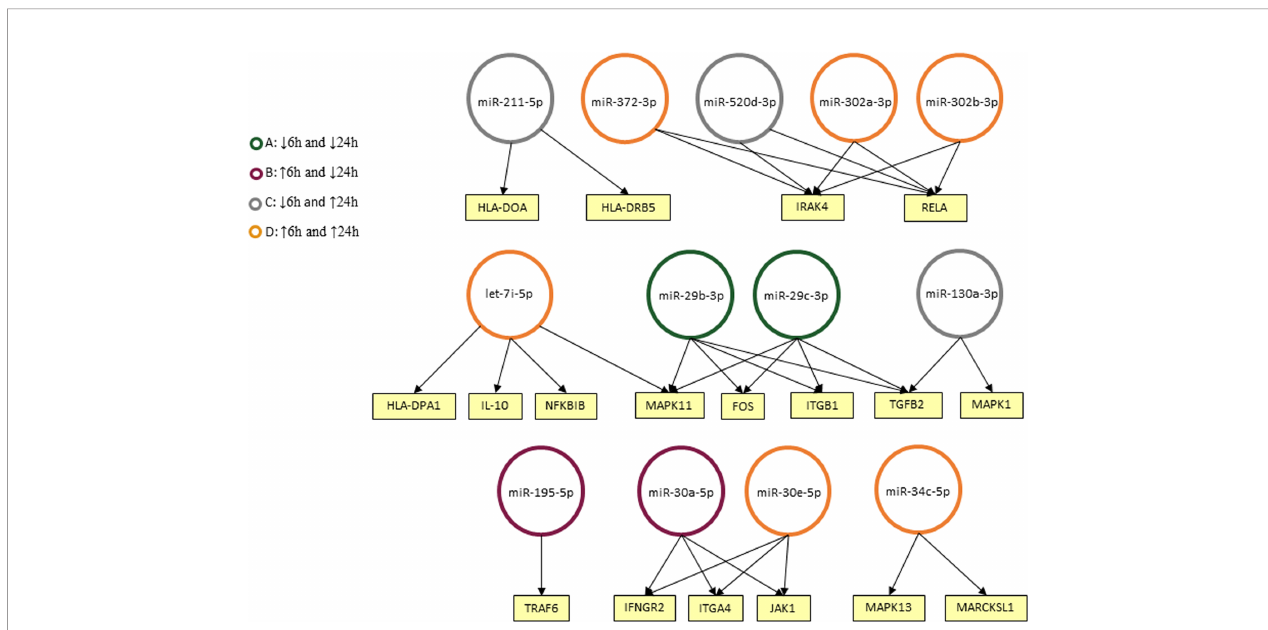
FIGURE 4 | Predicted interactions between the set of differentially expressed microRNAs in THP-1 cells after 6 and 24 h post infection. The genes on which they are suggested to act in the Leishmaniasis pathway in humans are shown as seen in KEGG. miRNAs were classi fi ed into four groups according to their modulation through time: down-regulated in 6 and 24 h (A) , up-regulated on 6 h and down-regulated in 24 h (B) , down-regulated in 6 h and up-regulated in 24 h (C) and up- regulated in both timepoints (D)